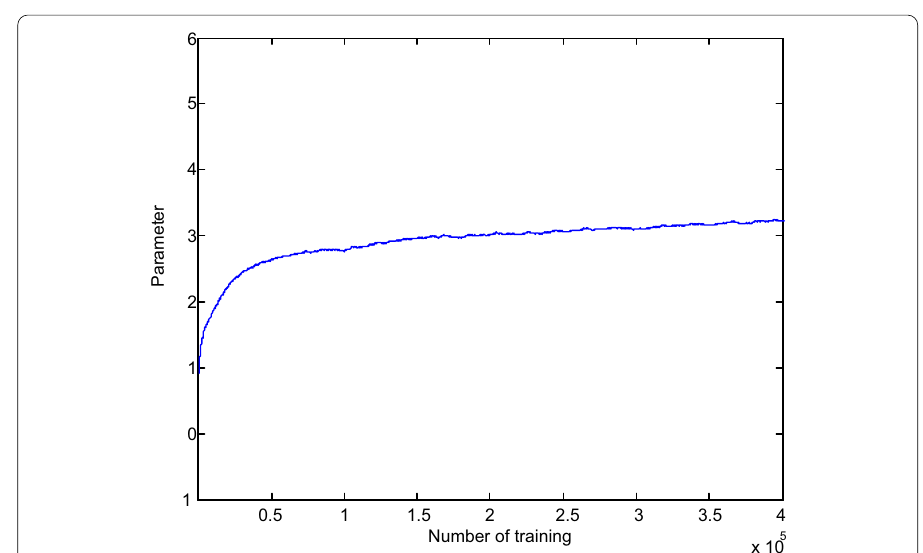
Fig. 8 Parameter convergence. This figure shows the relationship between the weight of the connection between the input layer neurons and the hidden layer neurons and the number of trainings. As shown in the figure, after 100,000 trainings, the weight parameters tend to be stable